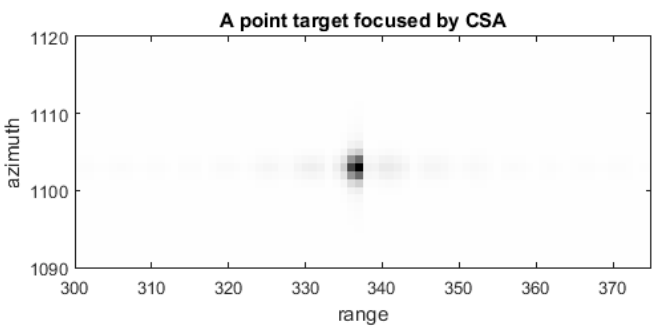
Figure 5. Simulated point target (time domain).